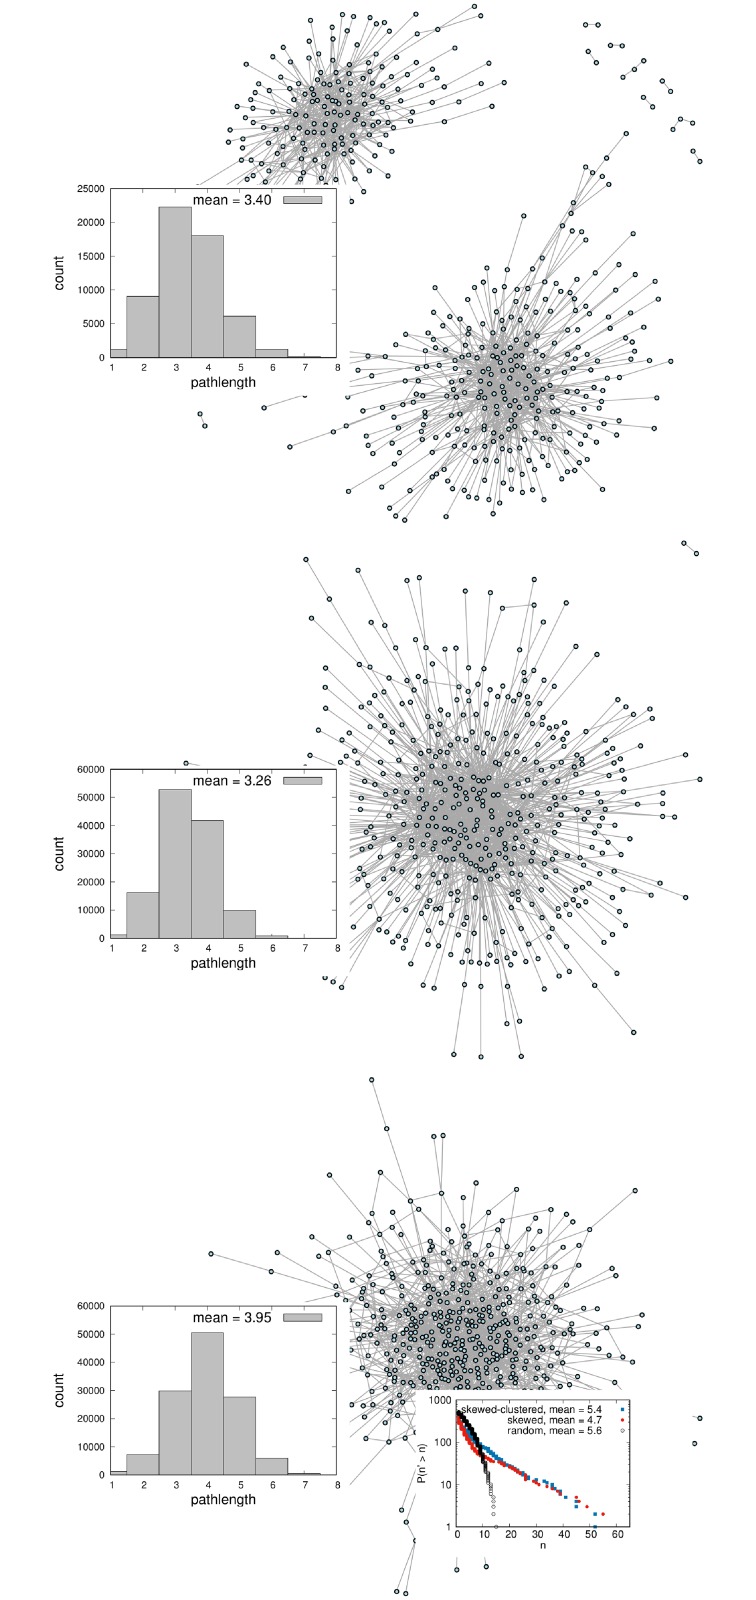
Topologies of a dynamic skewed-clustered network (top), a dynamic skewed network (middle) and a dynamic random network (bottom) at one point in time.Turnover rate (probability to leave the network in one timestep) δ = 0.1. The inlays on the left show the pathlength distribution. The skewed network has a much shorter pathlength than the random network (for same mean degree), and skewed-clustered network has slightly longer average pathlength, but still shorter than the random network. This relationship holds for a wide range of mean degrees. The inlay on the right shows the counter-cumulative degree distribution in loglinear scale, which are power laws with exponential cutoff for the skewed-clustered network and skewed network (blue and red), and binomial for the random network (black).